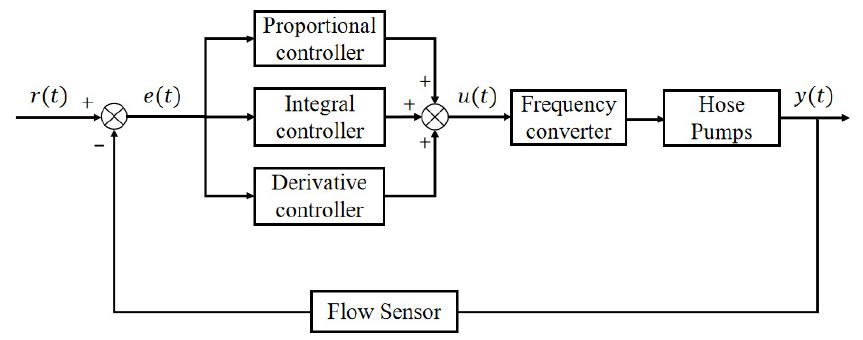
Figure 2. Conventional PID controller